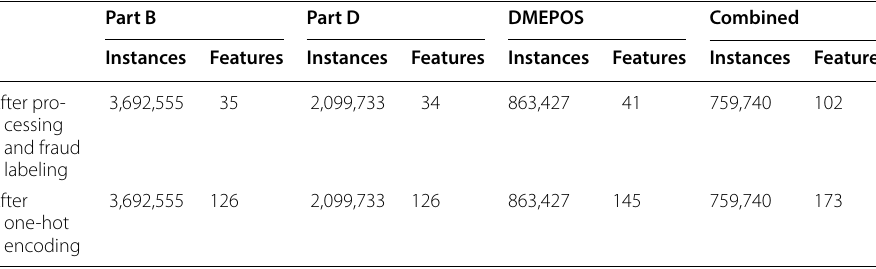
Table 10 Summary of Medicare